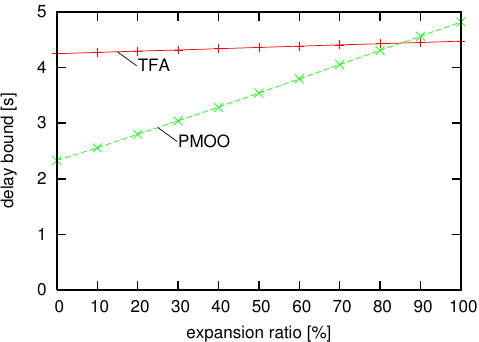
Figure 8. Investigation of PMOO vs. TFA under the drifting apart of maximum and minimum scaling